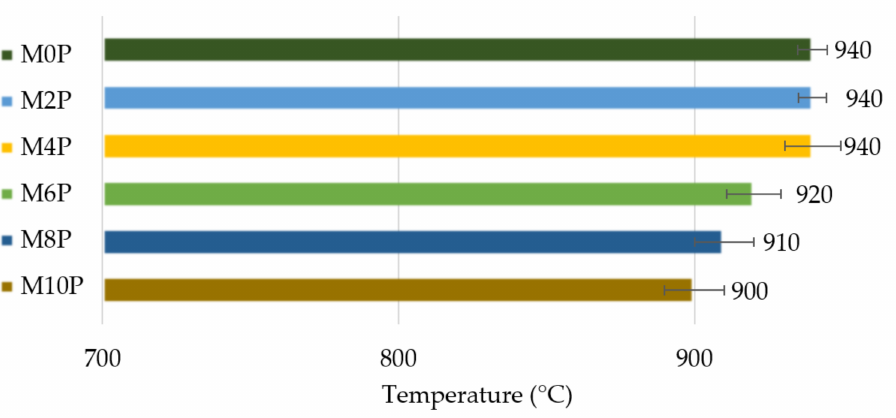
Figure 3. Pyrometric cone refractoriness of prepared matrices with different content of potassium